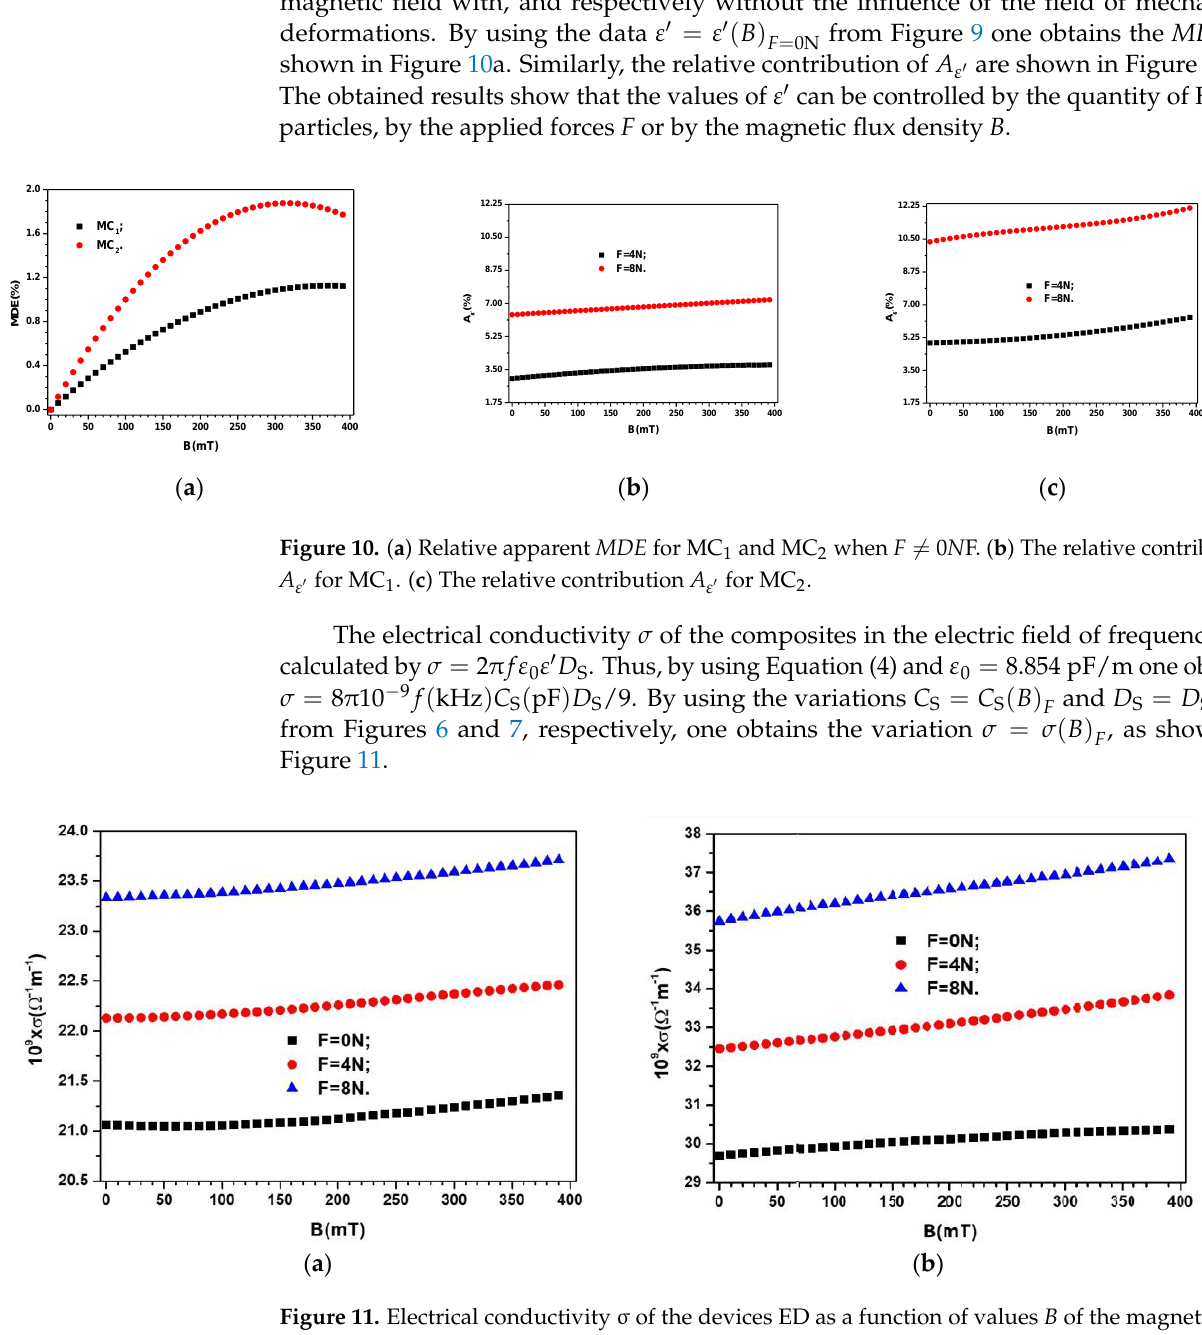
( b ) Figure 9. Relative dielectric permittivity 𝜀 ′ of the devices ED as a function of values B of the magnetic flux density superimposed on the electric field with the frequency f = 1 kHz, and values F of the force as a parameter. ( a ) MC 1 . ( b ) MC 2 . In order to quantify the influence of the magnetic field at F = 0 N, on the relative